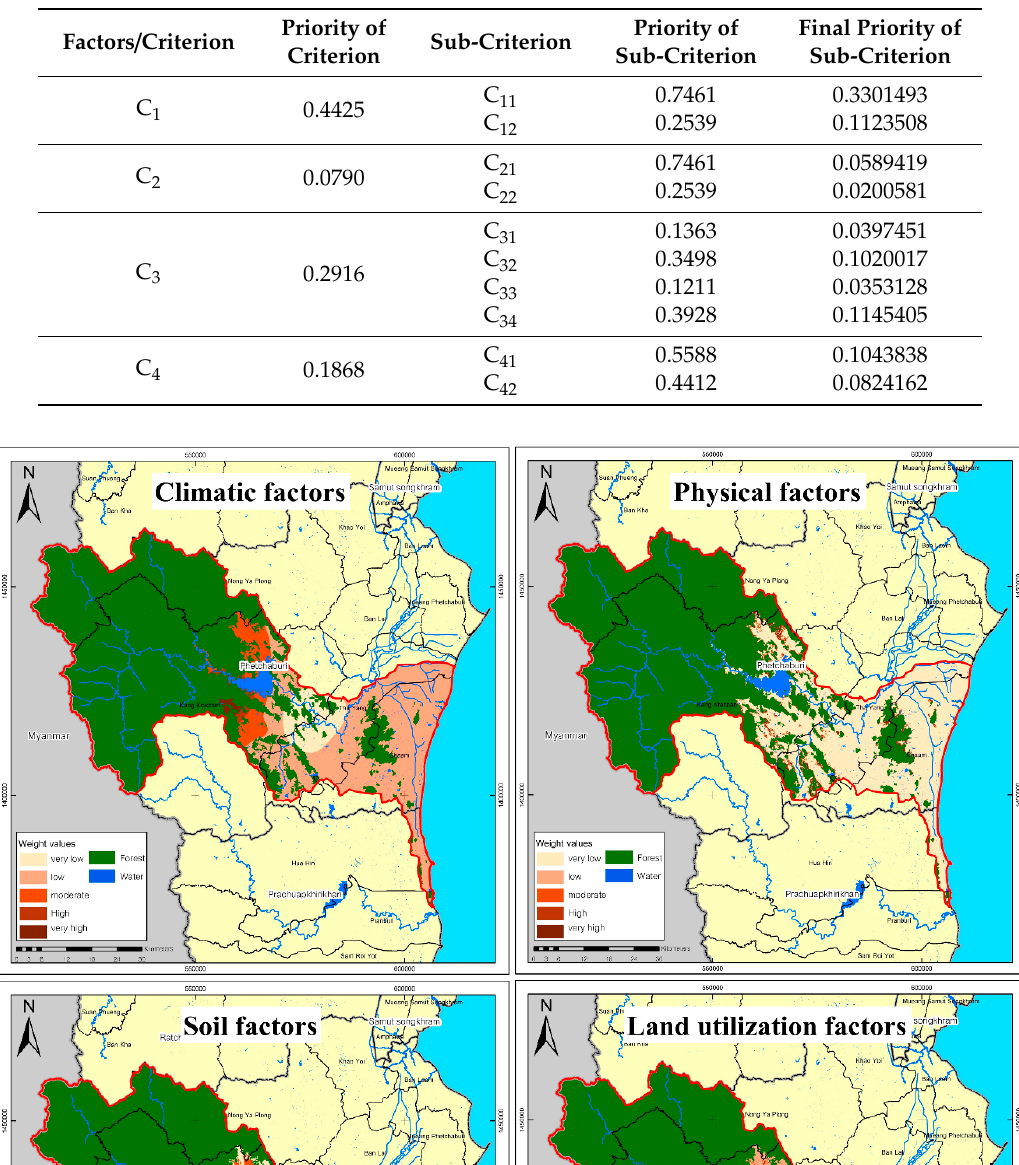
Table 4. Weight values of the drought risk factors assessed by fuzzy analytical hierarchy process (FAHP).